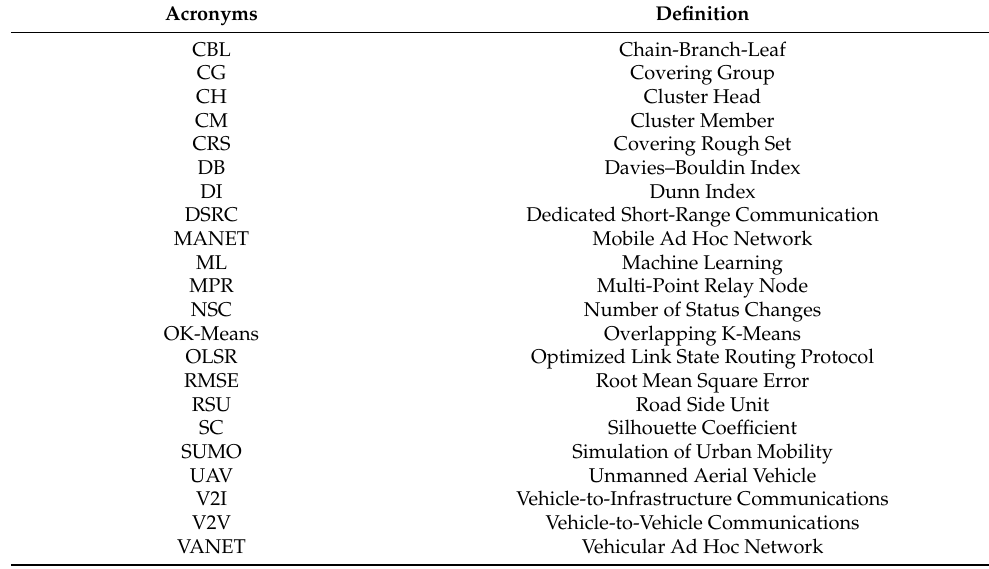
Table 1. List of notations and